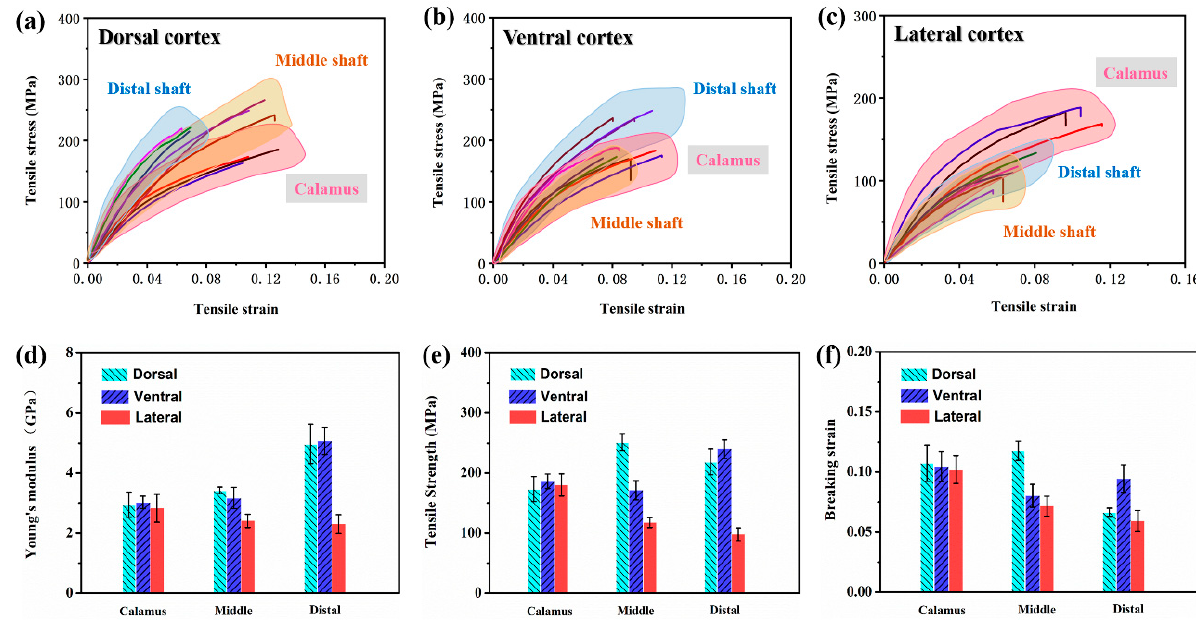
Figure 3. The tensile stress–strain curves of ( a ) dorsal, (b) ventral and ( c ) lateral cortex samples pro- cessed from calamus, middle and distal shaft, respectively; and the calculated ( d ) Young’s modulus, ( e ) flexural strength and ( f ) breaking strain of cortex samples (the error bar represents strand error for three samples).